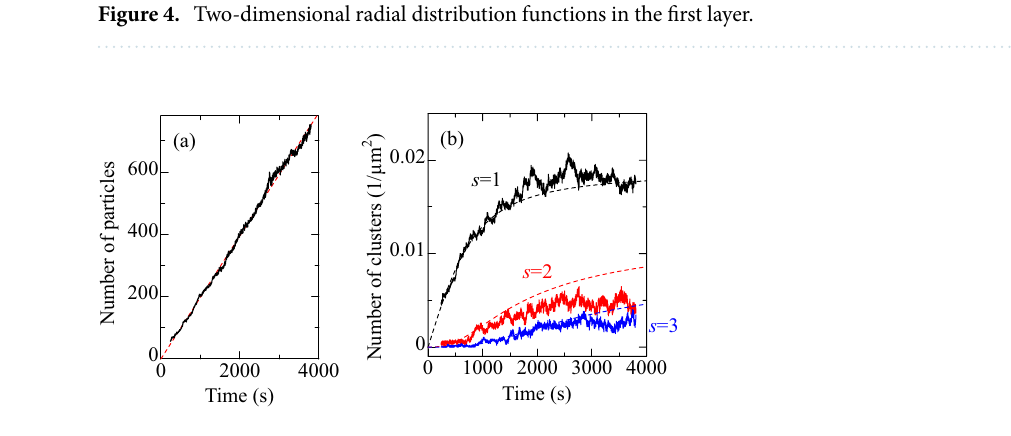
Figure 5. ( a ) Change in the number of particles on the coverslip. Deposition rate was determined from the fitted line (dashed line). ( b ) Changes in the number of clusters with 1, 2, and 3 particles. Solid lines denote the experimental results, and dashed curves denote the calculation